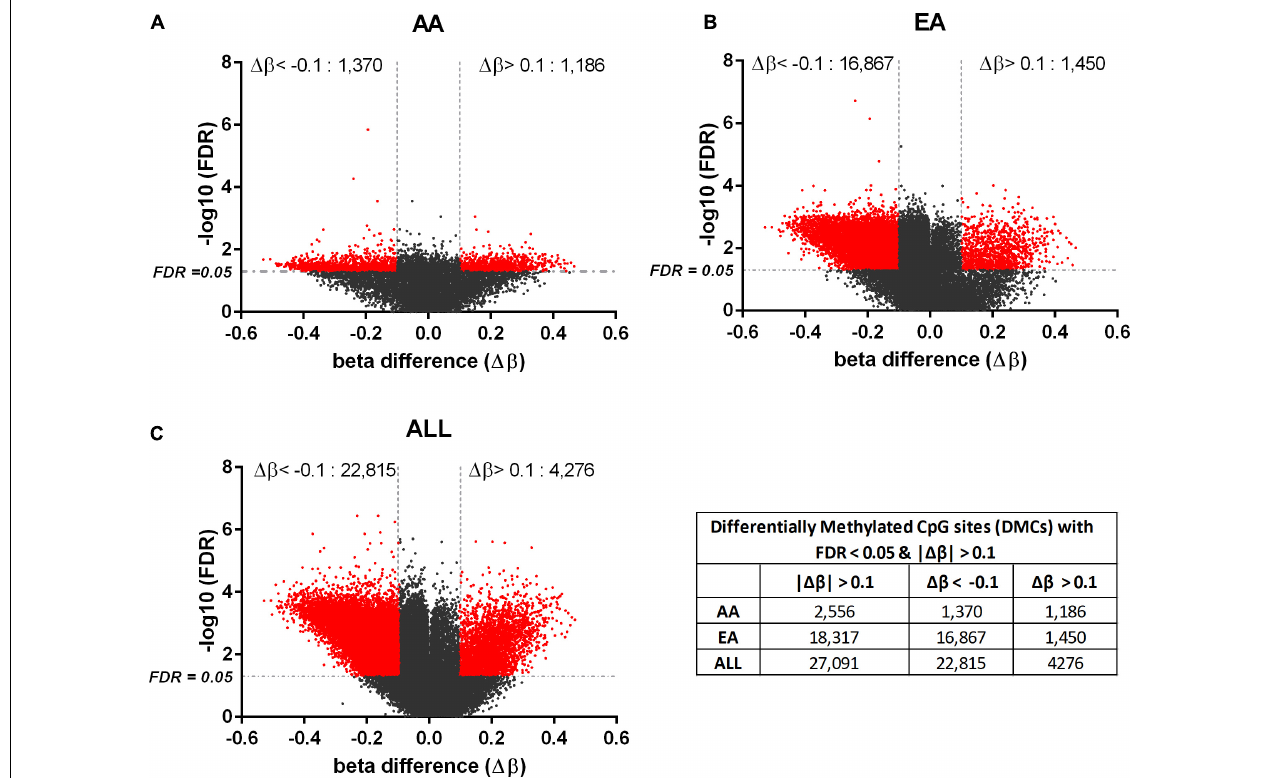
FIGURE 2 | Differentially methylated CpGs in tumor vs. non-tumor tissues in AA, EA, and AA+EA (ALL) combined. Volcano plot of the significant CpGs with FDR < 0.05 and | (cid:49) β | > 0.1 (shown in red). The methylated CpGs were identified by analyzing HCC vs. adjacent non-tumor tissues in AA (A) , EA (B) , and ALL (C) ; The beta difference is calculated as, (cid:49) β = [ β ( HCC ) – β ( adj . non − tumor ) ].